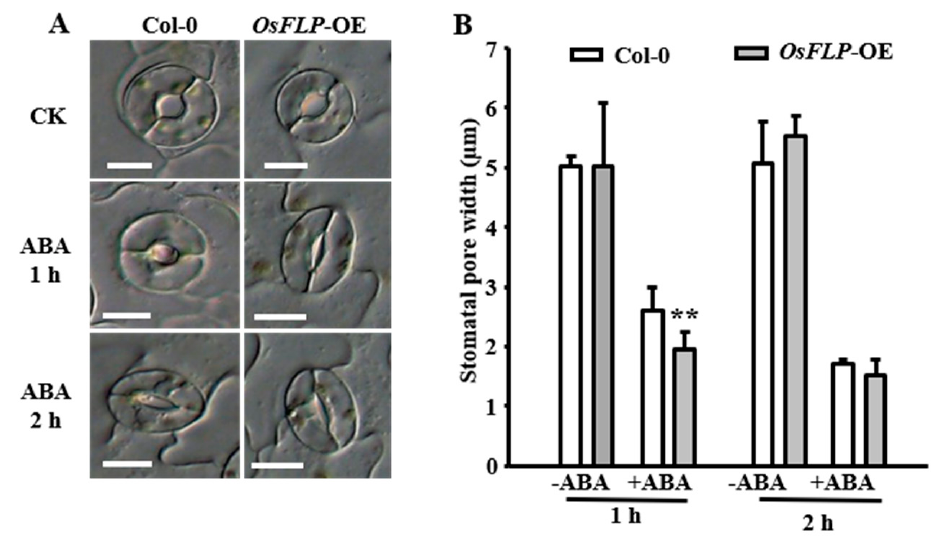
Figure 5. Overexpression of OsFLP enhanced the stomatal closure. ( A ) Representative images of Col-0 and OsFLP -OE stomata showing stomatal closure in response to ABA treatment for 1 h and 2 h. Bars = 10 µ m. ( B ) Quantification of stomatal pore width in Col − 0 and OsFLP -OE plants in response to 10 µ M exogenous ABA; the stomatal aperture is indicated by the ratio of stomatal width. Data presented are the mean ± SE of three independent biological replicates. Significant differences in comparison with the WT are indicated as ** p < 0.01 (Student’s t -test). To further identify the function of OsFLP in stomata, cross-species complementation tests were conducted. pMUTE:OsFLP is driven by Arabidopsis MUTE promoter (MUTE is a bHLH transcription factor and especially expressed in stomatal lineage) and 35S:OsFLP were introduced into Arabidopsis flp − 1 mutant, respectively. The stomatal cluster (4- GC) was partially rescued from 29% in flp − 1 mutant to 16% in 35S: OsFLP-OE lines, whereas it was completely rescued to normal in pMUTE:OsFLP flp − 1 plants (Supplemen- tary Figure S4), supporting that OsFLP is a conserved regulator in stomatal